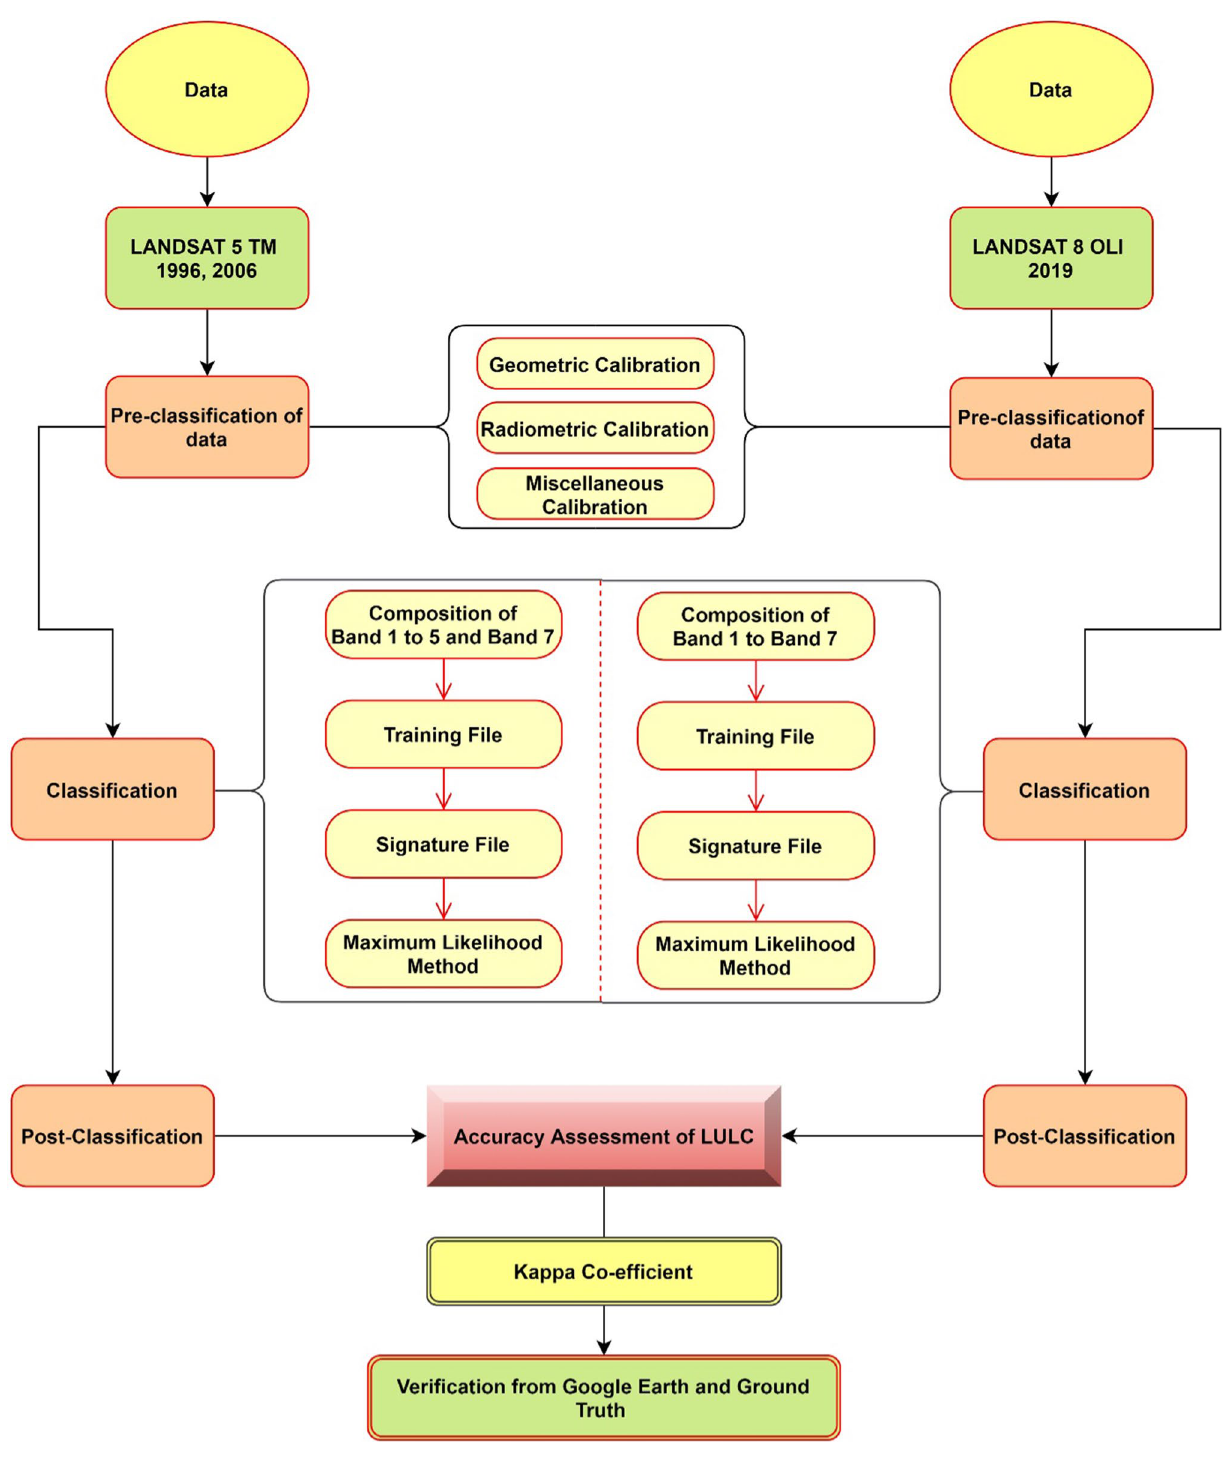
Fig. 5 Process to make landuse and landcover map with accuracy assessment. Source: